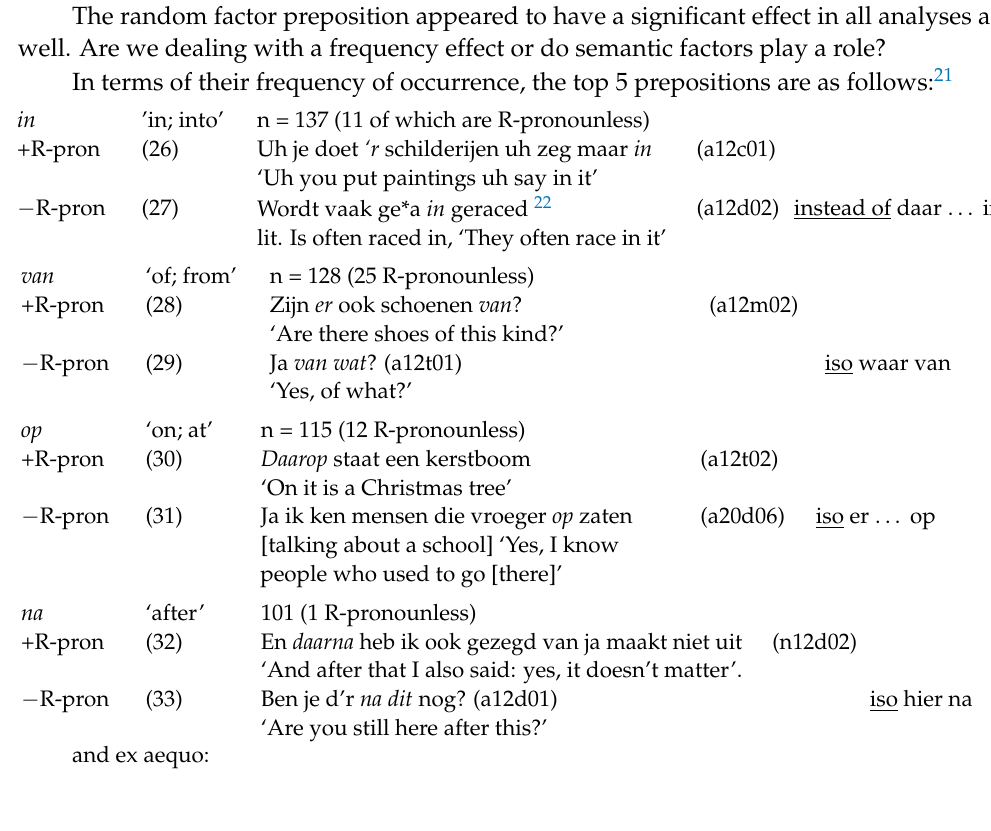
Figure 2. The relationship between R-word drop (estimated marginal means) and the language background ( above ) and the age group of the speakers ( below ).